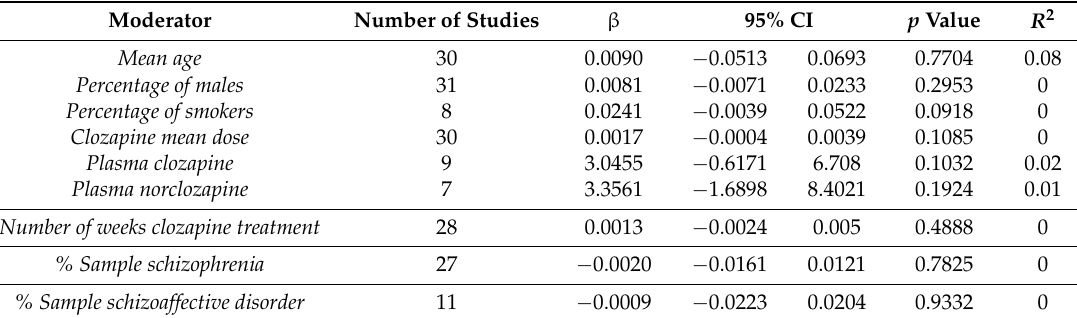
Table 2. Meta-regression of moderators of